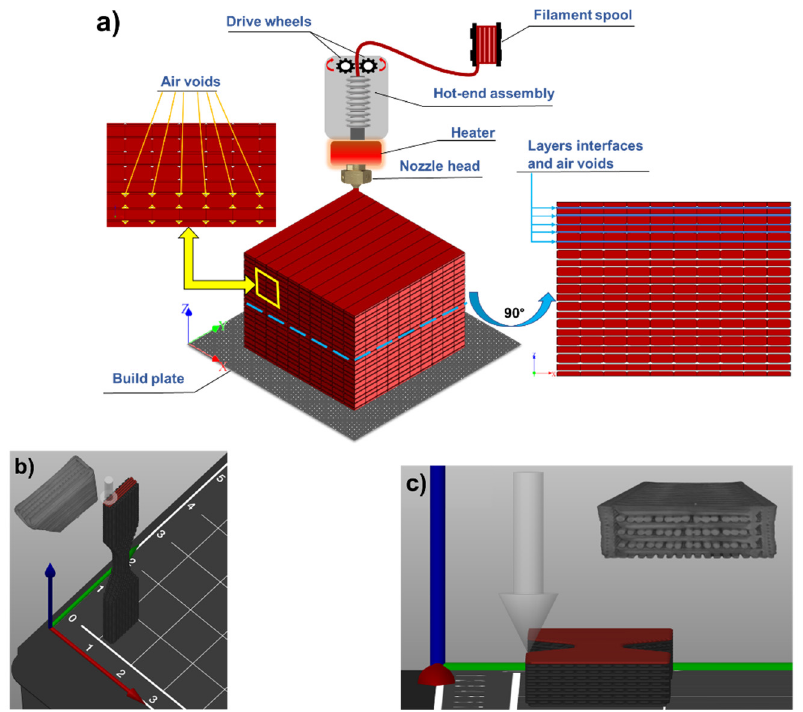
Figure 1. Schematic of FDM process: ( a ) FDM process and air voids formed throughout the sample; ( b ) transverse build orientation; and ( c ) longitudinal build